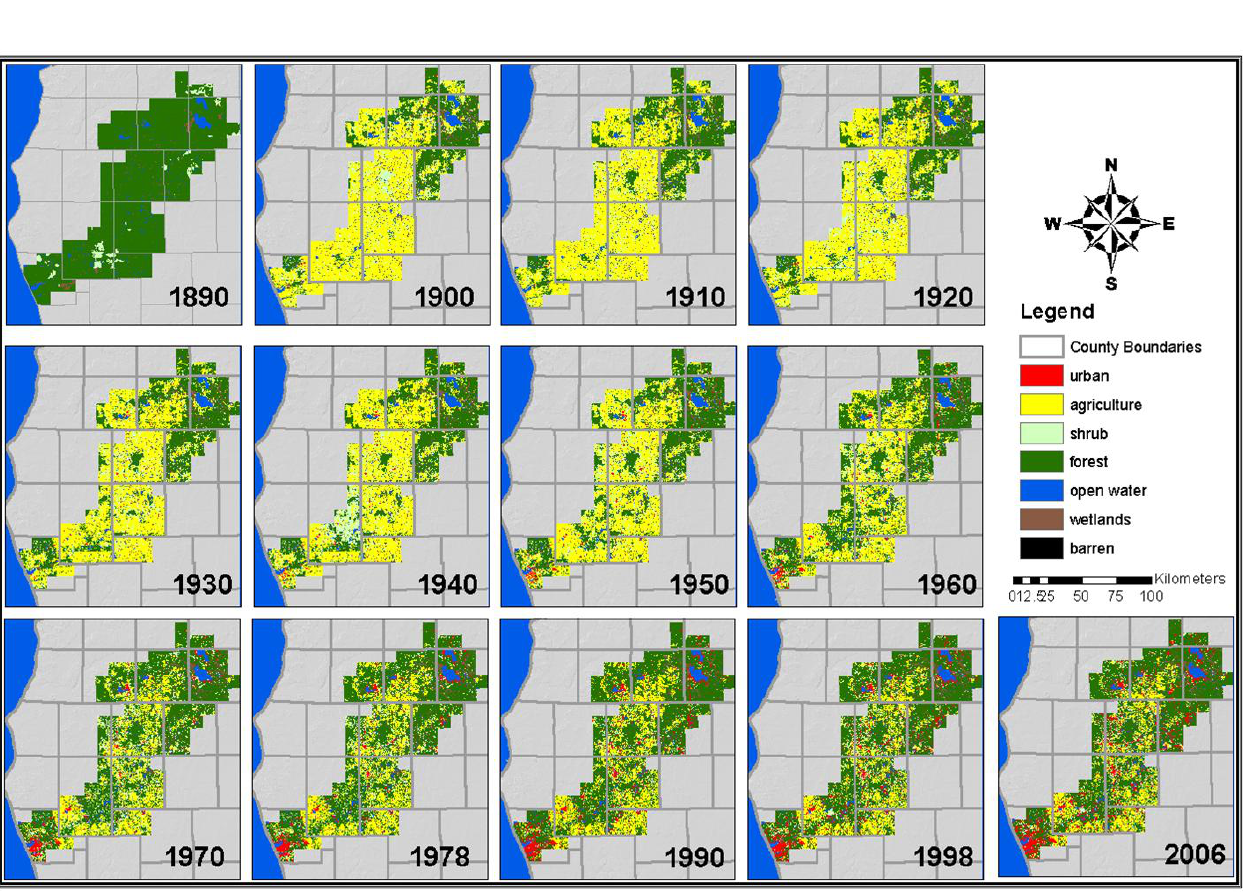
Fig. 6 . Land-use/cover maps generated by the land-change backcast model. Three of the maps represent actual data from 1890, 1978, and